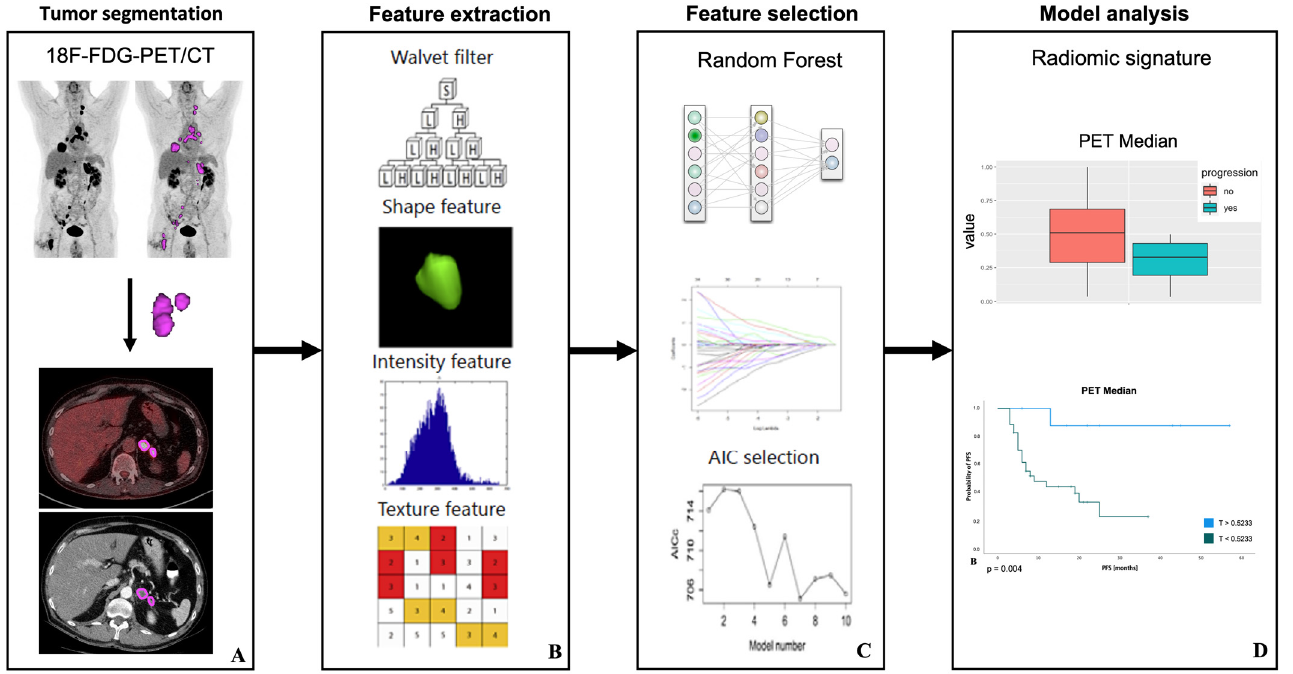
Figure 1. Radiomic features examination: PET positive volumes in baseline 18 F-FDG-PET-CT were defined by application of a standardized threshold (PERCIST criteria) and manual adjustments, then transferred to low-dose CT dataset ( A ). RF extraction from a specific generated label map volume was done using an open source and multi-platform software package called 3D-Slicer, Version 4.11.2 ( B ). A Radiomics-based model was built based on a Radiomics signature consisting of reliable RFs that allow classification of second follow-up response using multivariate logistic regression ( C ). For predicting second follow-up response, the area under the receiver operating characteristic curve and the threshold of the Radiomics-based model was generated. These features were additionally tested for their prognostic value (PFS) with Kaplan–Meier and log-rank tests in all patients by applying a model-derived threshold ( D ). Modified to Yang et al.